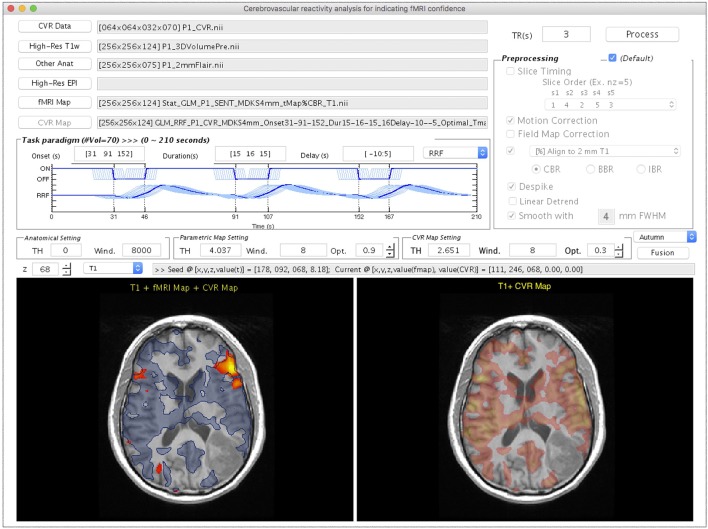
The GUI of the CVR Mapping module displayed with processing and visualization for Patient #1. This window consists of the imaging data input panel (Upper Left), breath-hold paradigm setting (Middle Left), preprocessing selection (Upper Right), visualization widget (Middle), and two visualization panels (Bottom Left and Right). The Bottom Left panel shows the task-fMRI activation overlays (t > 4.04, p < 10−4, uncorrected) on a high-resolution T1w image using the warm color map. The result of CVR mapping (t > 2.65, p < 0.01, uncorrected) displays as transparent blue with a solid blue contour. The area outside the CVR map, but inside potential functional anatomy near the lesion, indicates the location of possible NVU. The Bottom Right panel shows the CVR map using a warm color map.